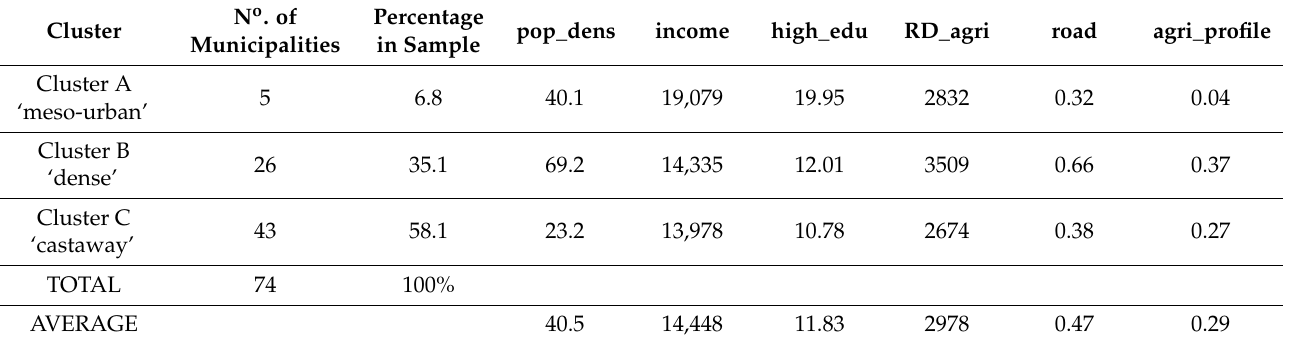
Table 2. Mean values of the six indicators collected for all PR municipalities by